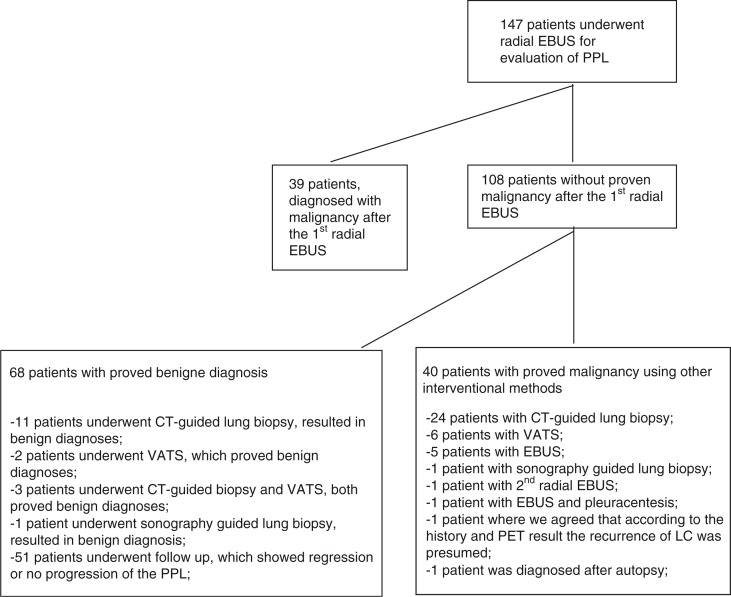
Flow diagram illustrating diagnostic work-up of all the patients with PPLs.